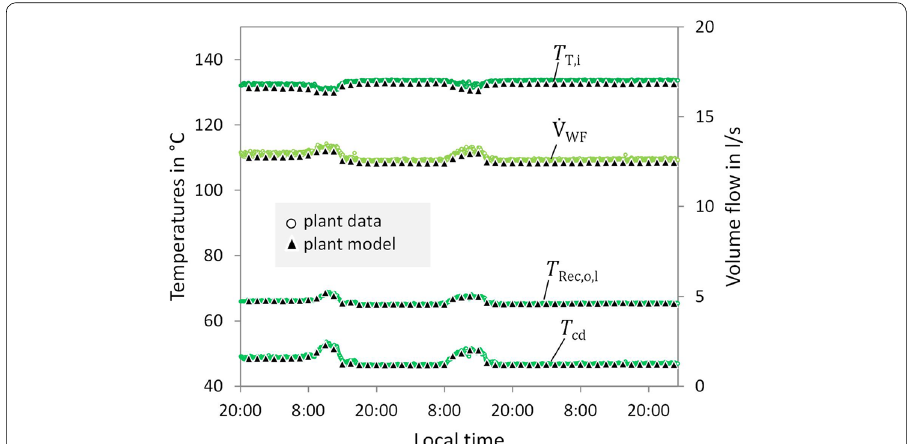
Fig. 14 N-pentane temperatures and volumetric flow—comparison of modeled and real plant data for Plant data for 48 h operation